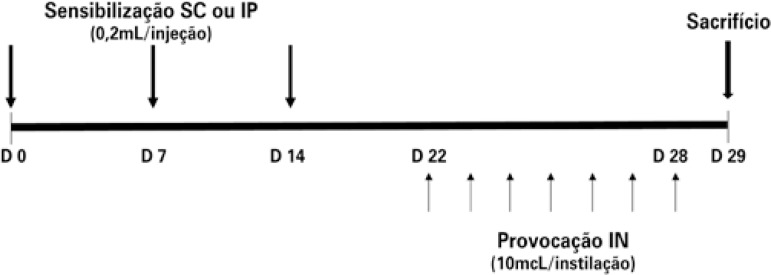
Esquema do protocolo de sensibilização, provocação e sacrifício com duração de 30 dias (D0 a D29)